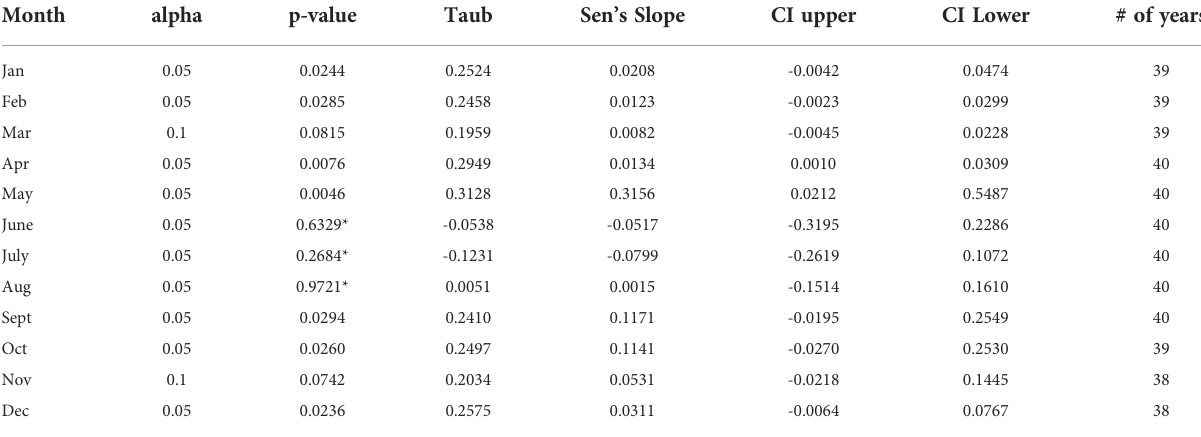
TABLE 5 Mann-Kendall trend statistics from monthly volume